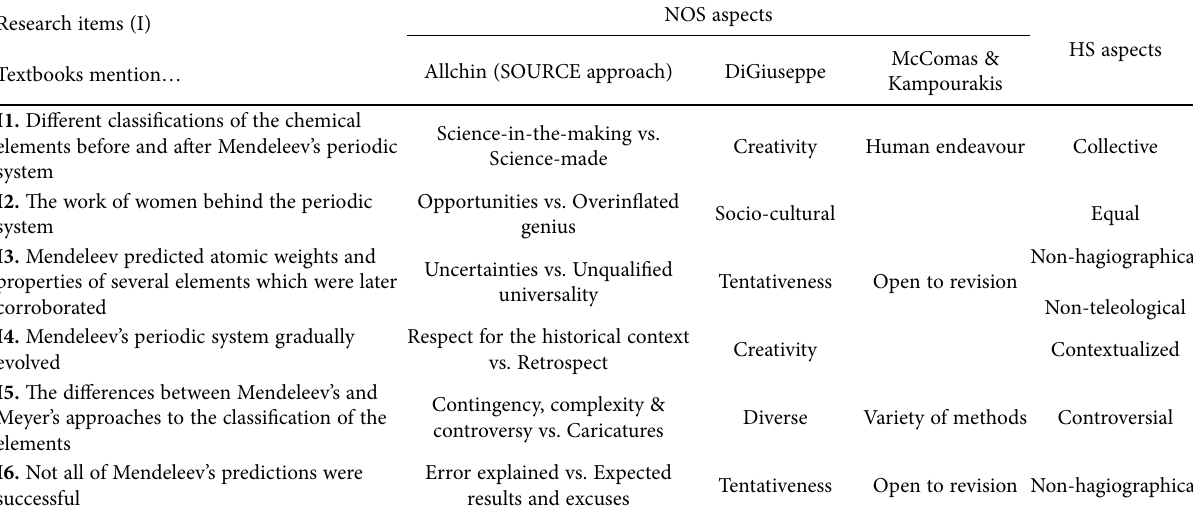
Table 3. The SOURCE approach adapted to the history of the classification of the chemical elements. For an explanation of S, O, U, R, C and E, see Table